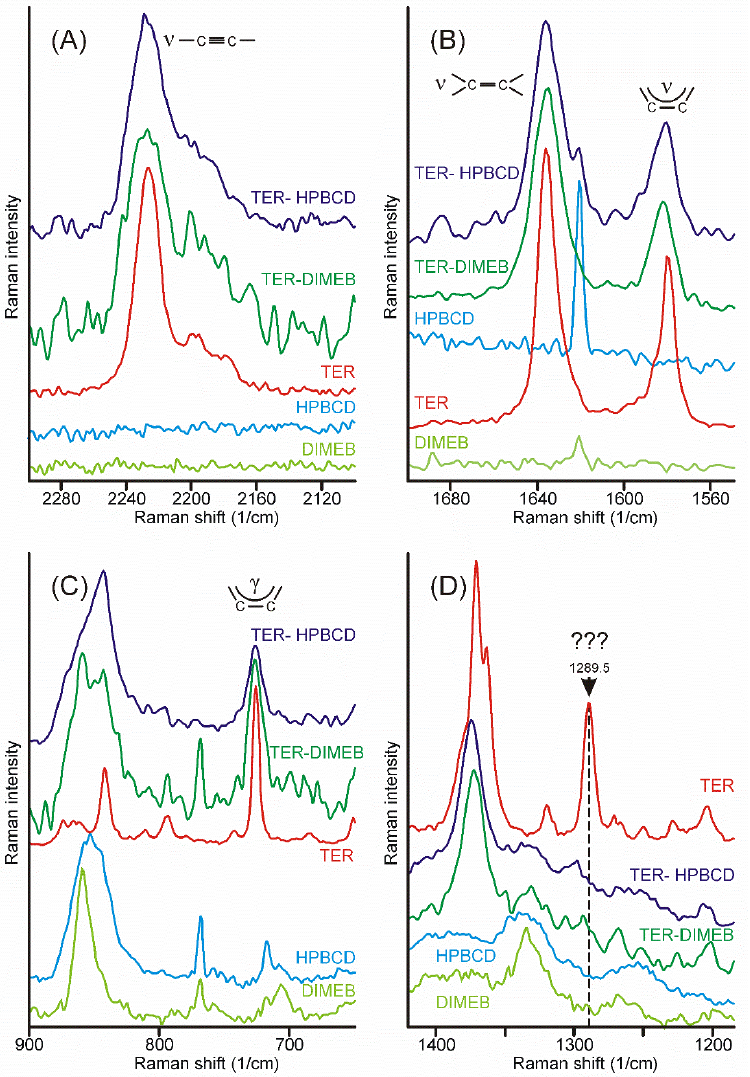
Figure 8. Most of the characteristic peaks in the Raman spectra of crystalline TER overlap with the bands of the products, except the one at 1289.5 cm − 1 , in the fingerprint region. ( A )—region of the stretching band of the carbon–carbon triple bond, ( B )—region of the stretching bands of the carbon–carbon double bond and those of the aromatic rings, ( C )—region of the out-of-plane deformation bands of the aromatic rings, ( D )—region containing the useful peak for the characterization of the presence and the distribution of crystalline TER in the